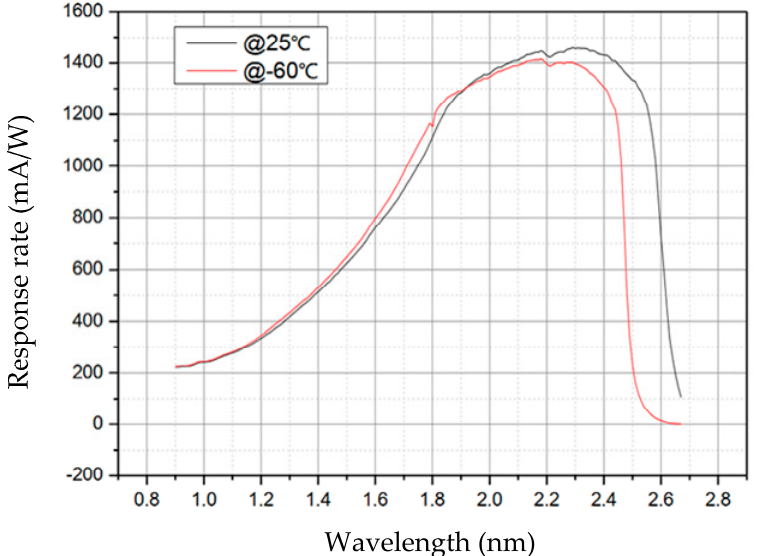
Figure 4. Example of the photosensitivity temperature dependence of detector used in the PSAC 2250 nm channel. Two PSTs used for comparison are independent of RTDC experiments.